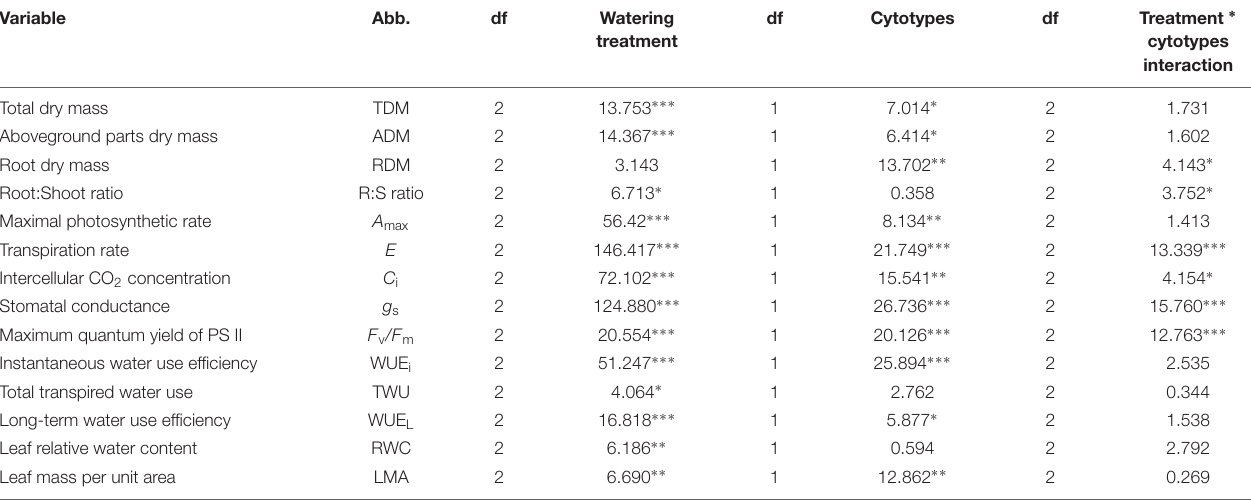
TABLE 2 | Comparisons of all variables measured in this experiment for diploid and hexaploid C. angustifolium seedlings. Variable